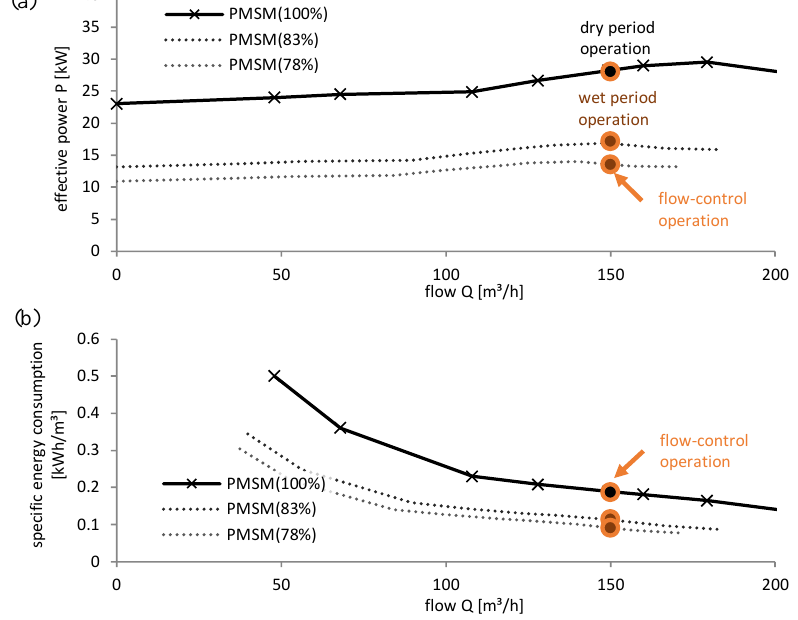
Figure 8. ( a ) Effective power and ( b ) specific energy consumption vs flow for the investigated PMSM Figure 8. (a) Effective power and (b) specific energy consumption vs flow for the investigated PMSM pump at 100%, 83%, and 78% speed levels. pump at 100%, 83%, and 78% speed